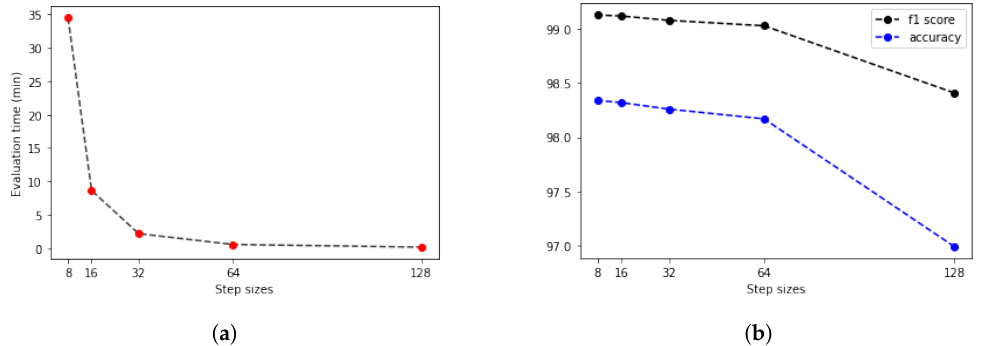
Figure 13. Parameter searching and validation to find the best step size considering time and accuracy. ( a ) Evaluation time depending on step sizes. ( b ) F1 score and accuracy